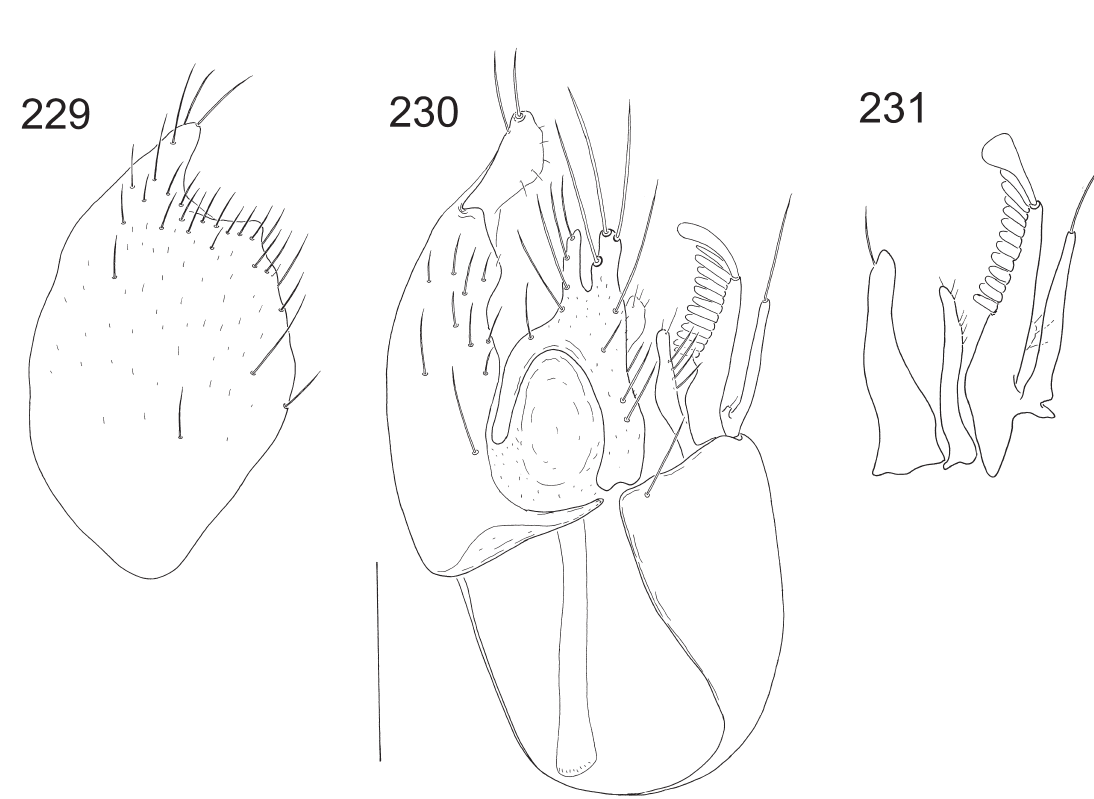
Figs 229-231. Stilpon singaporensis sp. nov., ♂. 229 . right epandrial lamella, lateral view. 230 . epandrium with cerci, dorsal view. 231 . left surstylus, lateral view. Scale bar= 0.1